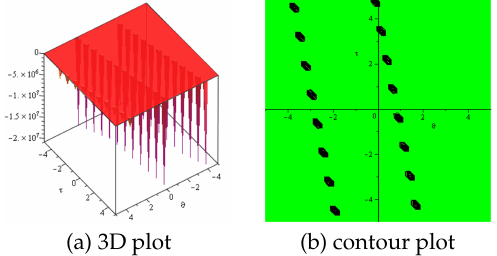
Fig. 1. 3-D and contour plots of the solution ¯ h 1 ( τ , η , ϑ ) with parameters β = 3, α = 3, δ = 1, B = e , p = 0.97, q = 0.97, Υ = 1, Θ = 2, I = 1, η =